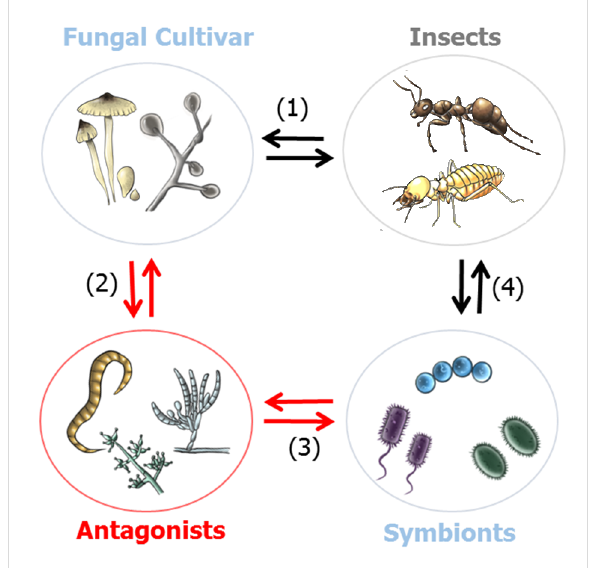
Figure 4: Multilateral microbial interactions in fungus-growing insects. (1) Insect cultivar: protects and shares habitat and nutrients. (2) Cultivar antagonist: competition for nutrients and habitat. (3) Antag- onist mutualist: competition for nutrients and habitat; detrimental infes- tation by antagonist. (4) Symbiont insect: (beneficial) coexistence by sharing and protecting habitat and nutrients.